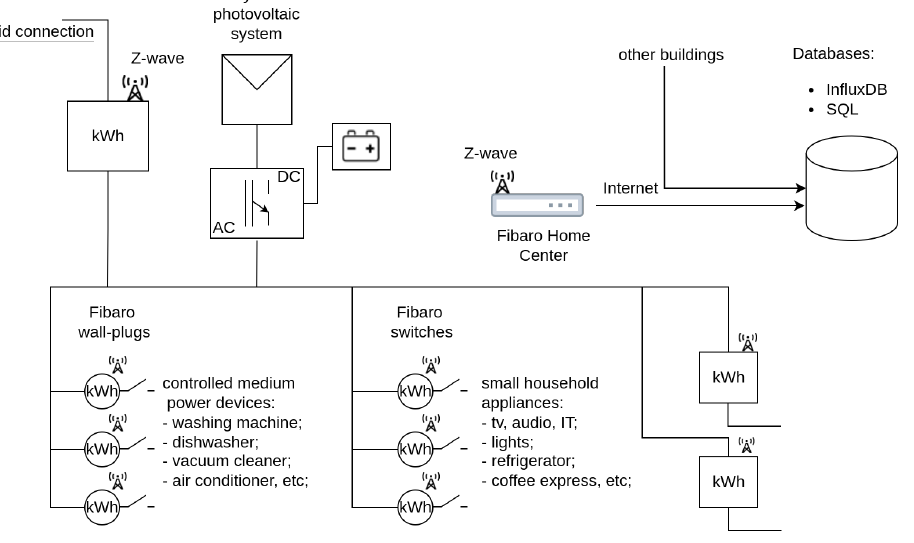
Figure 1. Schema of the digital-twin model of a